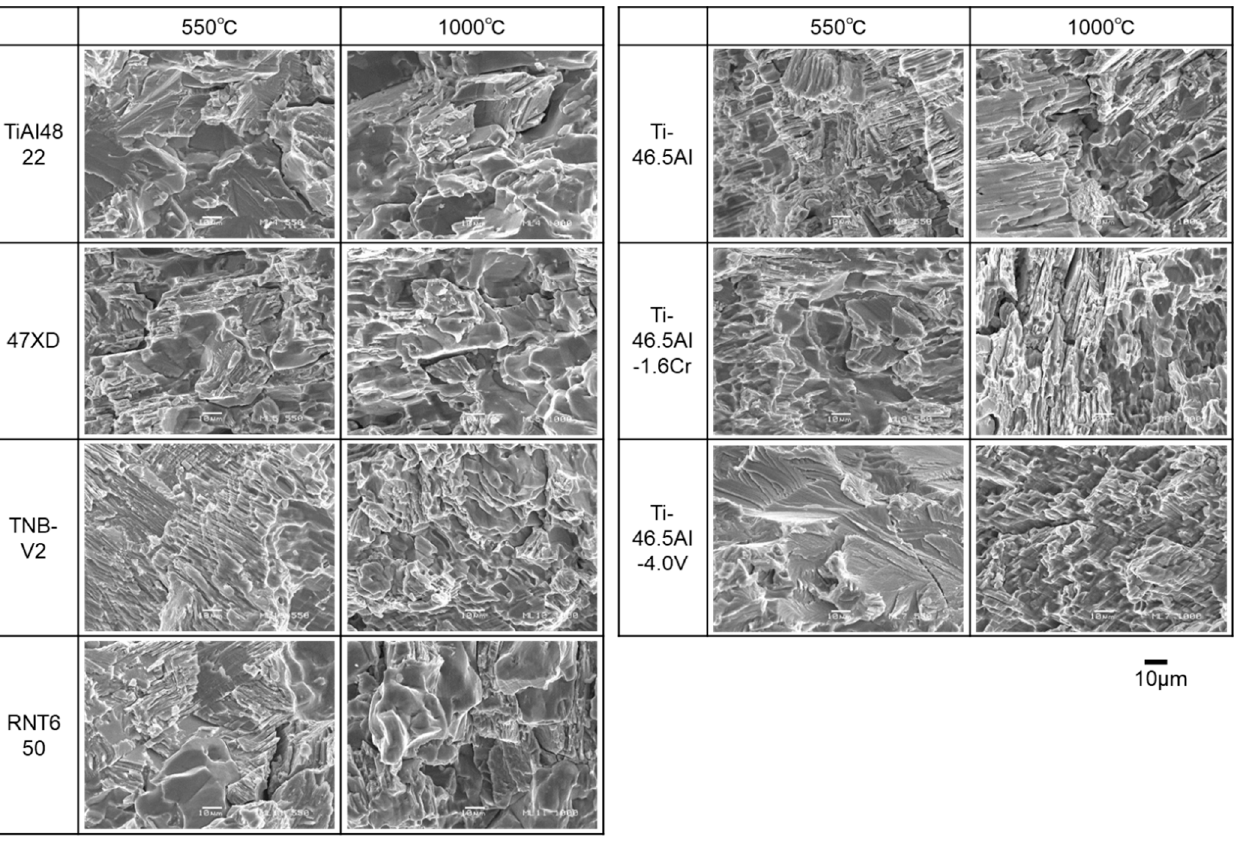
Figure 6. Secondary electron images showing the fractured surfaces of TiAl cast alloys tested by Charpy impact tests at 550 and 1000 °C.